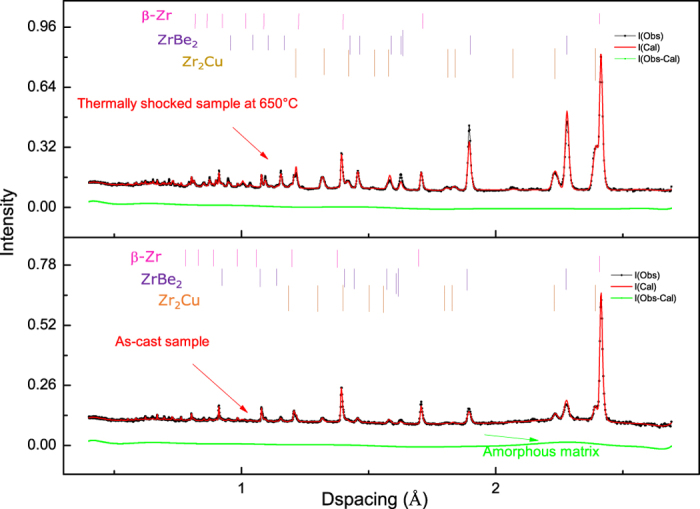
The neutron diffraction spectra and fittings for the thermally shocked and as-cast samples.Neutron diffraction spectra for (a) the sample thermally-shocked to 650 °C, showing profile fits for the β-Zr, ZrBe2, and Zr2Cu phases, and (b) the as-cast sample with fits for the β-Zr, amorphous matrix, ZrBe2 and Zr2Cu phases.